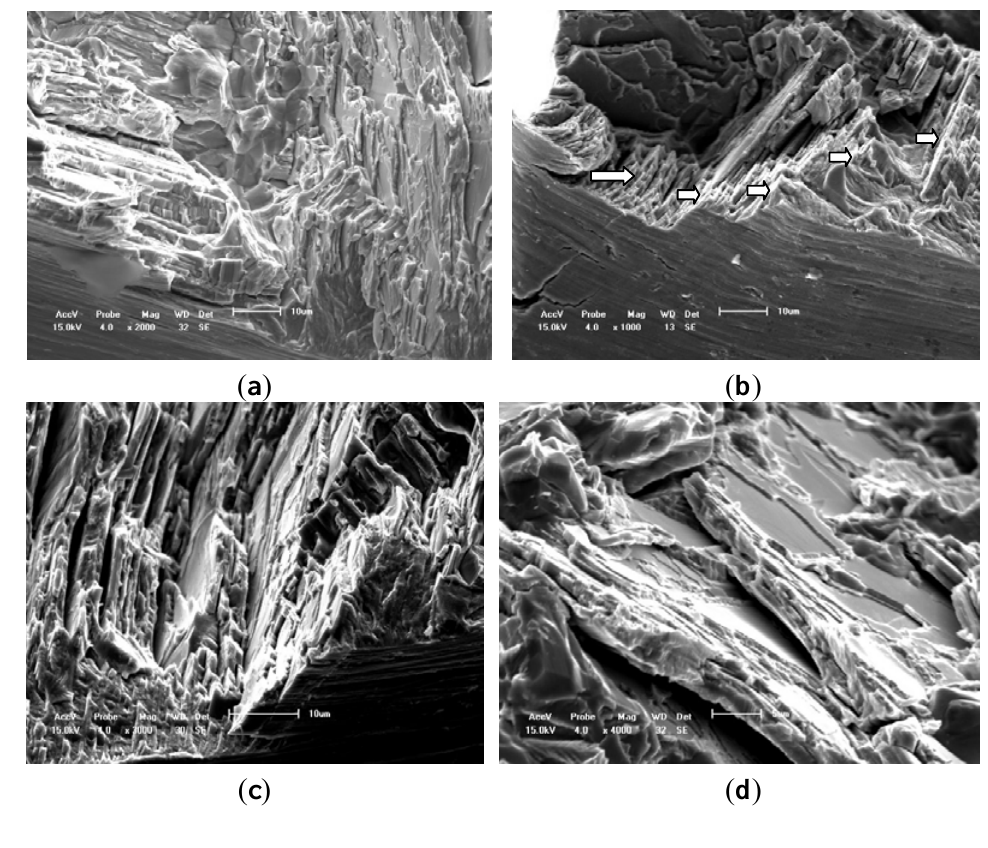
Figure 6. Fatigue fracture characteristics of TiAl alloy with 8% Nb content at 750  C. ( a ) Scale bar 10  m; ( b ) Scale bar 10  m; ( c ) Scale bar 10  m; ( d ) Scale bar 5  m (Interlamellar